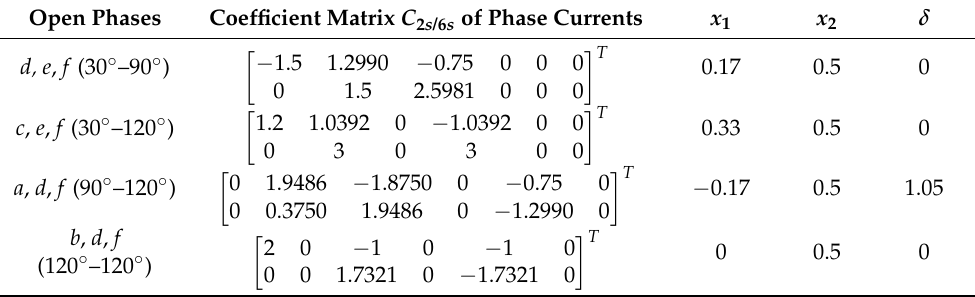
Table 5. Per-Unit Maximum Phase Current under Different Three-Phase-Open Fault-Tolerant Control Strategies; the Redundancy and Copper Loss Ratios. Table 5. Per ‐ Unit Maximum Phase Current under Different Three ‐ Phase ‐ Open Fault ‐ Tolerant Table 5. Per ‐ Unit Maximum Phase Current under Different Three ‐ Phase ‐ Open Fault ‐ Tolerant Control Strategies; the Redundancy and Copper Loss Ratios. Table 5. Per ‐ Unit Maximum Phase Current under Different Three ‐ Phase ‐ Open Fault ‐ Tolerant Table 5. Per ‐ Unit Maximum Phase Current under Different Three ‐ Phase ‐ Open Fault ‐ Tolerant Control Strategies; the Redundancy and Copper Loss Ratios. Table 5. Per ‐ Unit Maximum Phase Current under Different Three ‐ Phase ‐ Open Fault ‐ Tolerant Control Strategies; the Redundancy and Copper Loss Ratios. Control Strategies; the Redundancy and Copper Loss Ratios. Control Strategies; the Redundancy and Copper Loss Ratios.